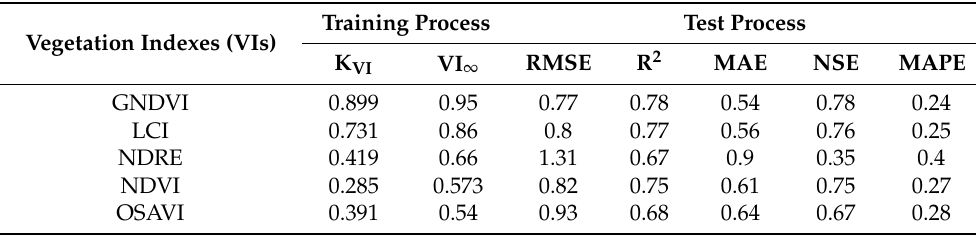
Figure 5. Relationship between the observed and estimated leaf area index (LAI) of rice by Semi-Empirical Model (SEM) with vegetation indexes (VIs) in the test process. Dash lines and red solid lines are the 1:1 lines and linear fitting lines respectively. The shaded areas indicate the range of 95% prediction bands. Table 1. Parameters and statistical indexes of leaf area index (LAI) semi-empirical model (SEM) for the vegetation indexes (VIs) inversion.